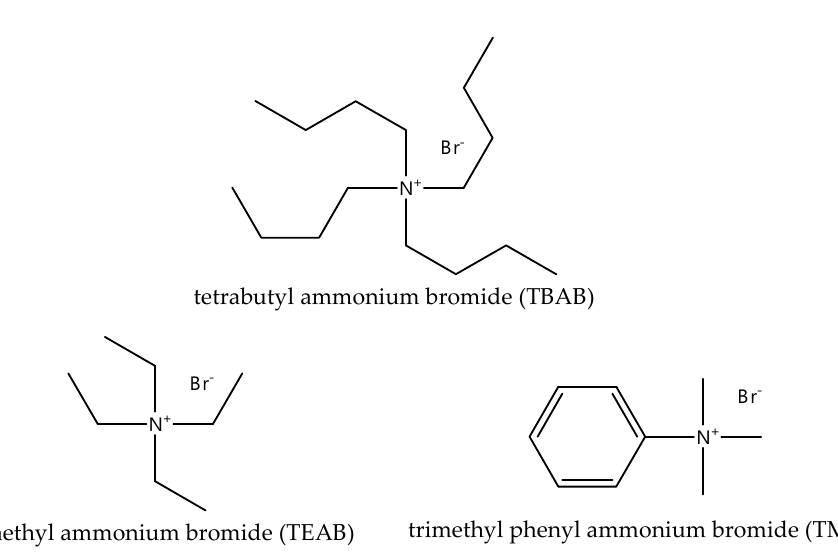
Figure 4. Structure of three quaternary ammonium salts.